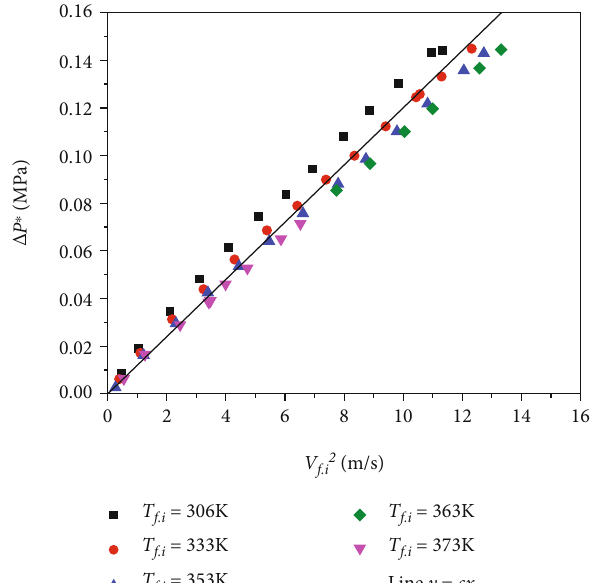
Figure 18: Variation of total pressure loss coe ffi cient of pilot fuel circuit.